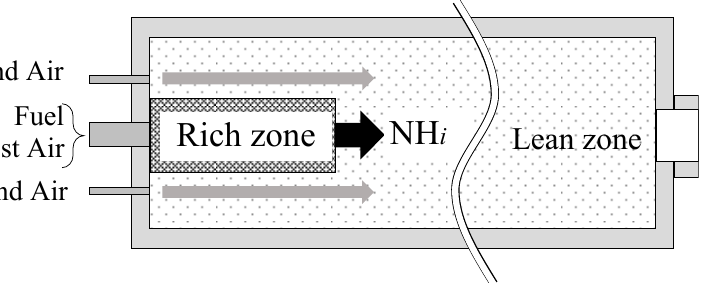
Figure 11. Image of the combustion region formed by two-stage combustion with parallel independent jets.